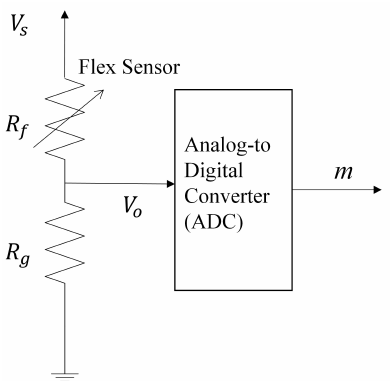
Figure 5. System for the acquisition of sensory data from a flex sensor, which can be viewed as a variable resistor with resistance value R f . The other resistor has a fixed resistance value R g . The V s and V o are the voltage supplied by the battery module, and the potential difference across R g , respectively. The value m is the output of ADC when V o is its input.